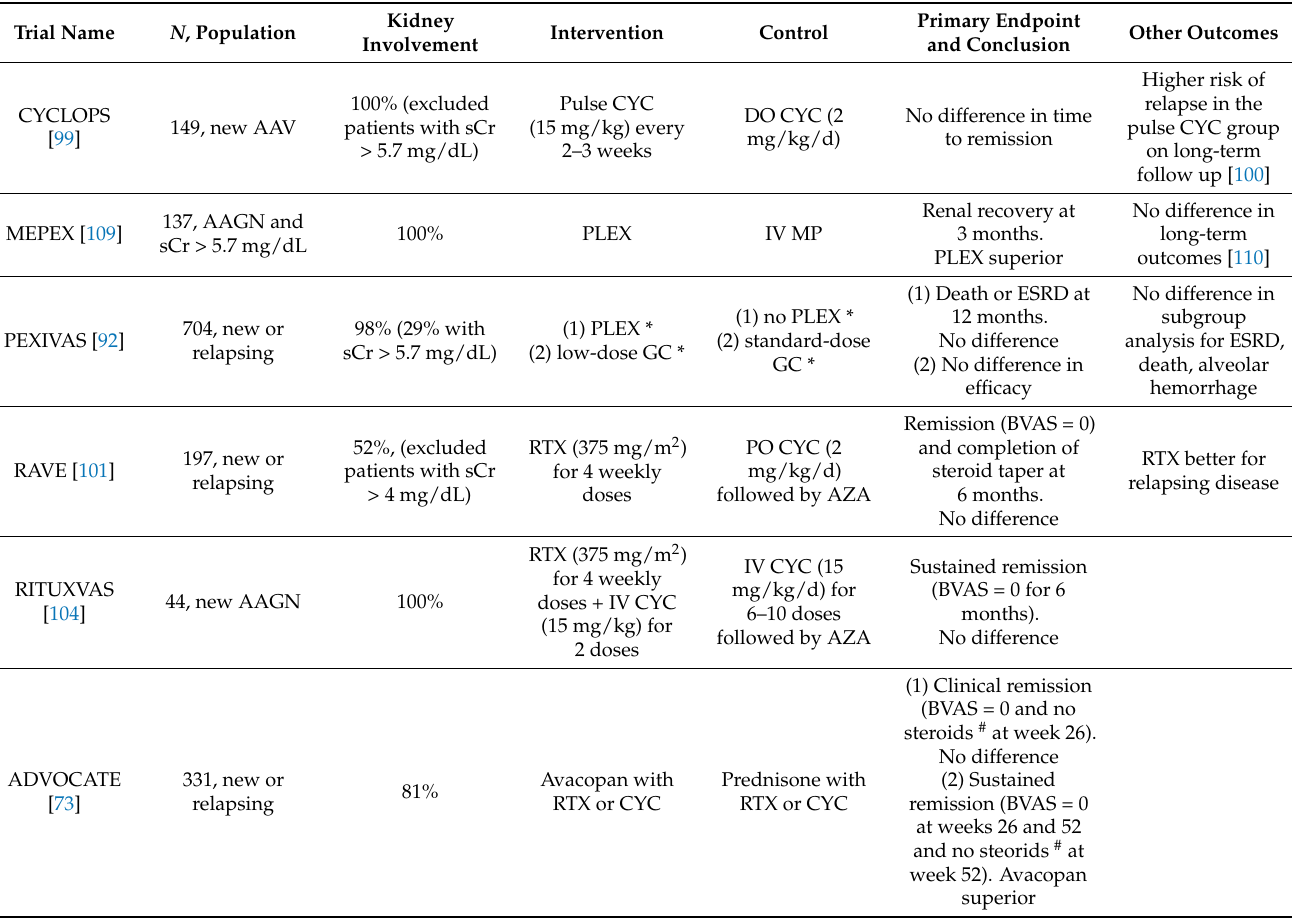
Table 4. Major clinical trials for induction therapy in ANCA-associated